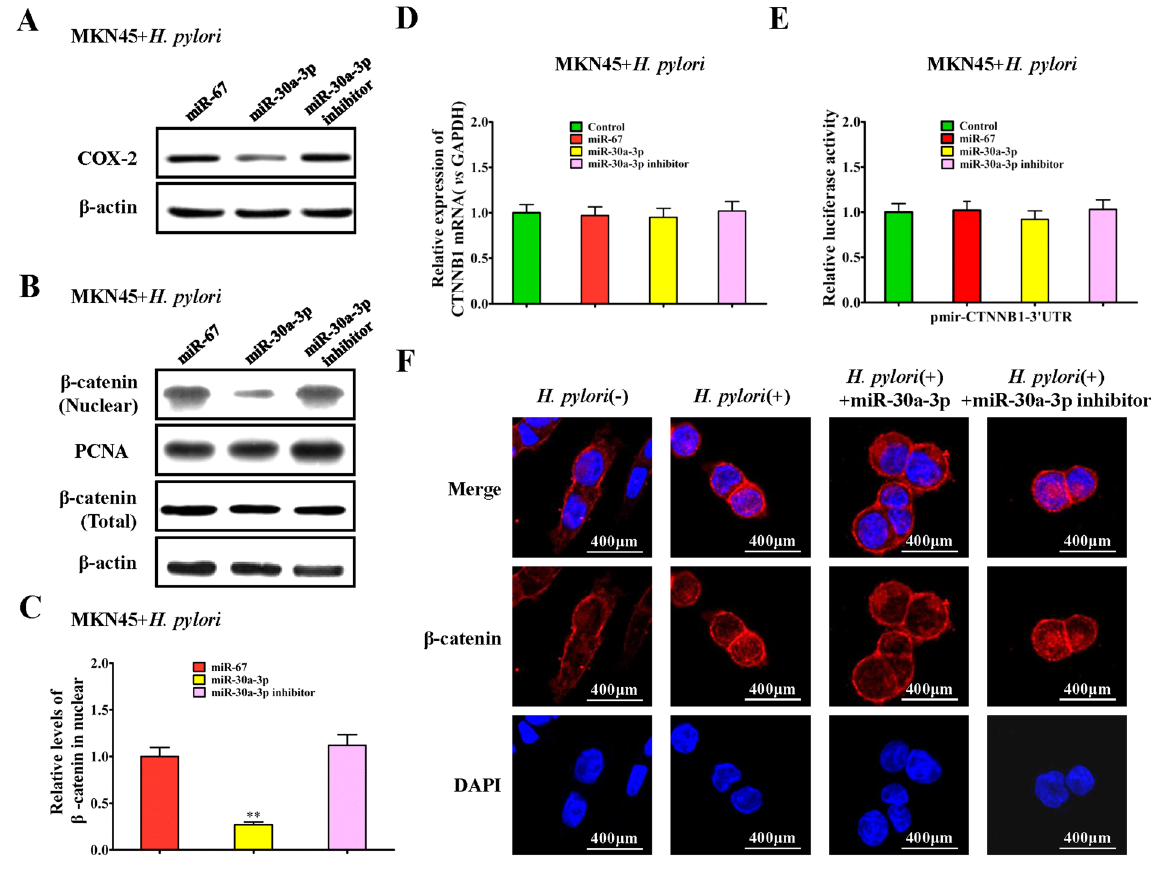
Figure 3. Regulation of miR-30a-3p on the COX-2 and β -catenin signaling pathway in H. pylori -infected gastric cancer cells. ( A ) Western blot assay for the effect of miR-30a-3p mimic and miR-30a-3p inhibitor on the COX-2 protein in H. pylori -infected MKN45 cells. ( B , C ) Western blot and quantitative assay for the effect of miR-30a-3p mimic and miR-30a-3p inhibitor on the nuclear translocation of β -catenin protein in H. pylori - infected MKN45 cells, normalized to H. pylori -infected MKN45 cells treated with miR-67 mimic. ( D ) qRT-PCR assay for the effect of miR-30a-3p mimic and miR-30a-3p inhibitor on β -catenin mRNA expression in H. pylori - infected MKN45 cells, normalized to control H. pylori -infected MKN45 cells. ( E ) Luciferase reporter activities assay for the effect of miR-30a-3p mimic and miR-30a-3p on the LEF/TCF promoter in H. pylori -infected MKN45 cells, normalized to control H. pylori -infected MKN45 cells. ( F ) Immunofluorescence β -catenin staining in H. pylori infected MKN45 cells transfected with miR-30a-3p mimic or miR-30a-3p inhibitor for 72 hours, and the H. pylori -infected MKN45 cells and H. pylori -uninfected MKN45 cells were the controls. Cell nuclei were stained with